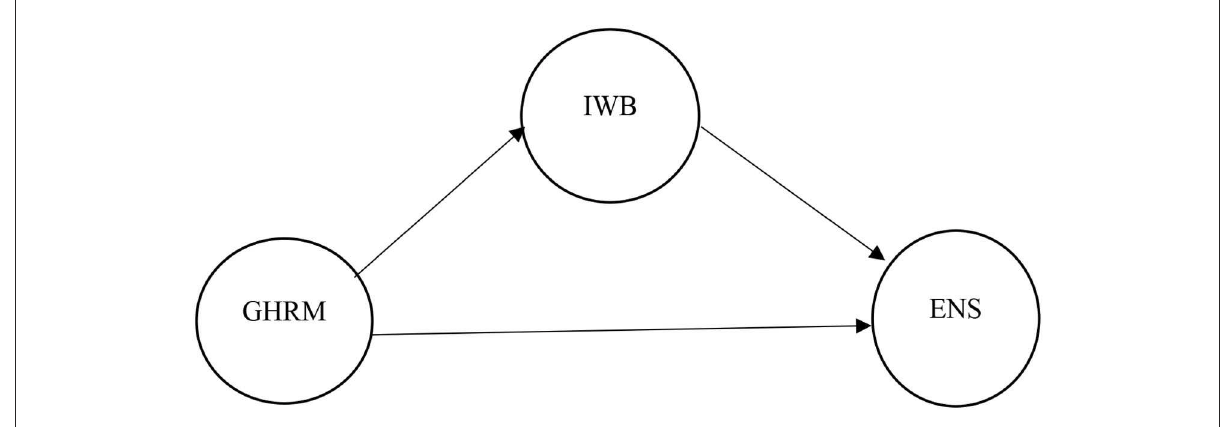
FIGURE1 Conceptual